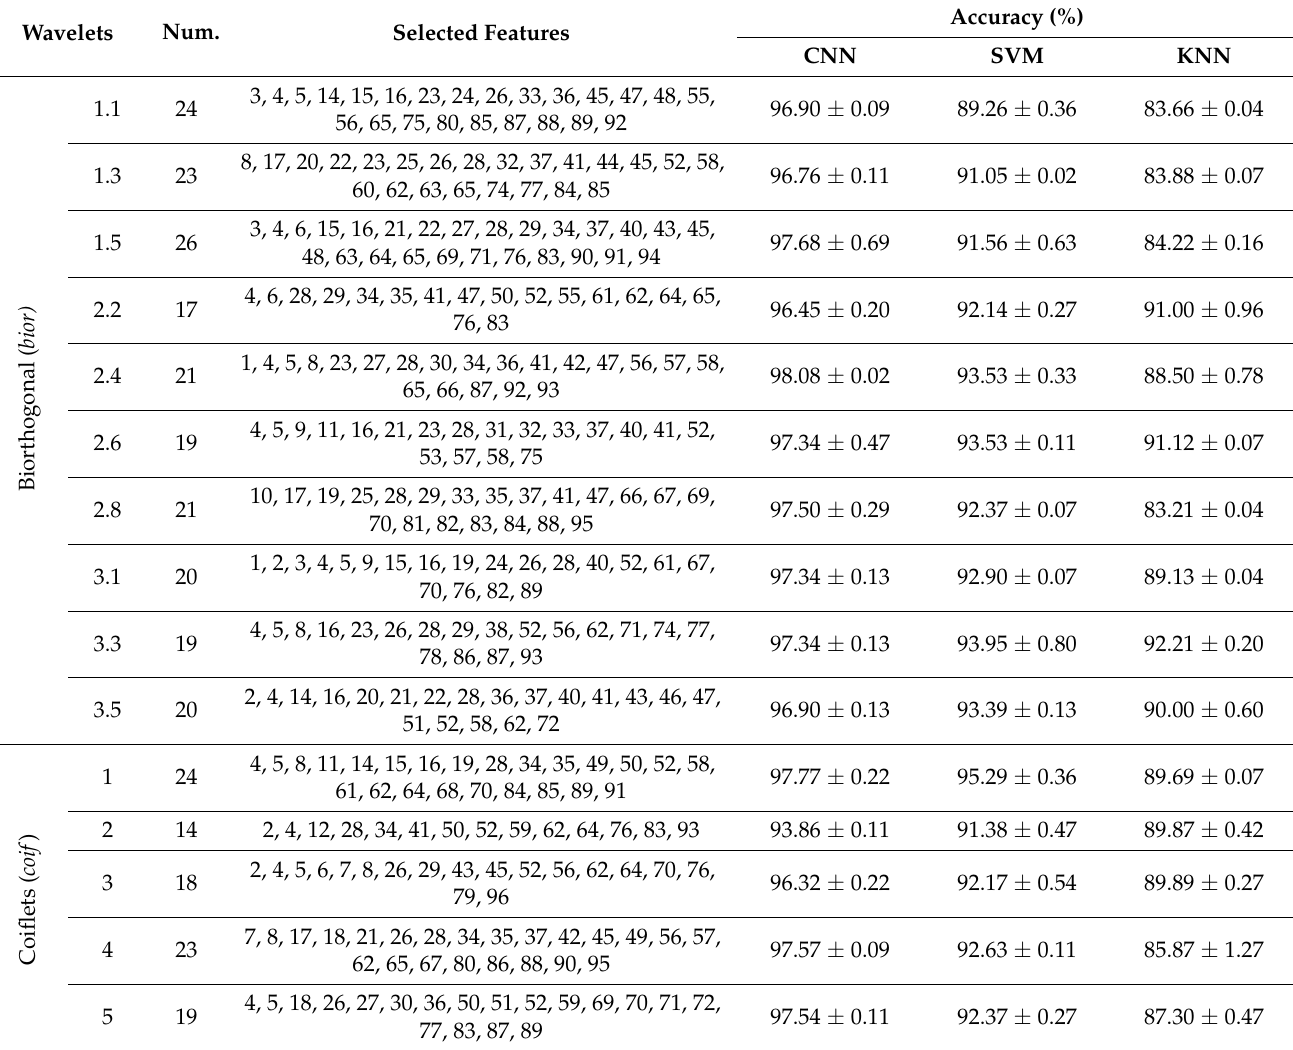
Table 6. The performance of the classifiers for selected features by the FPA-SVM wrapper approach. Accuracy (%) Wavelets Num. Selected Features CNN SVM